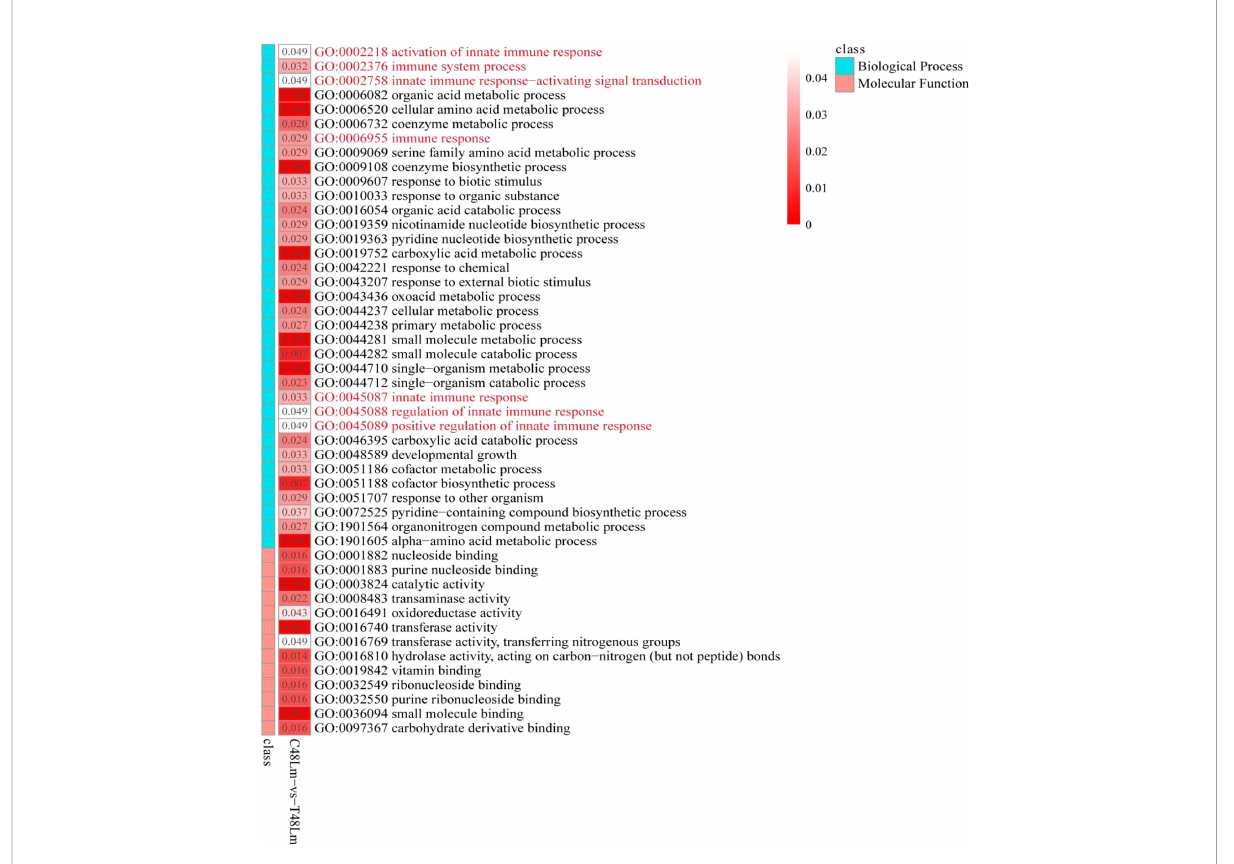
FIGURE 2 GO enrichment analysis of DEGs between C48Lm and T48Lm